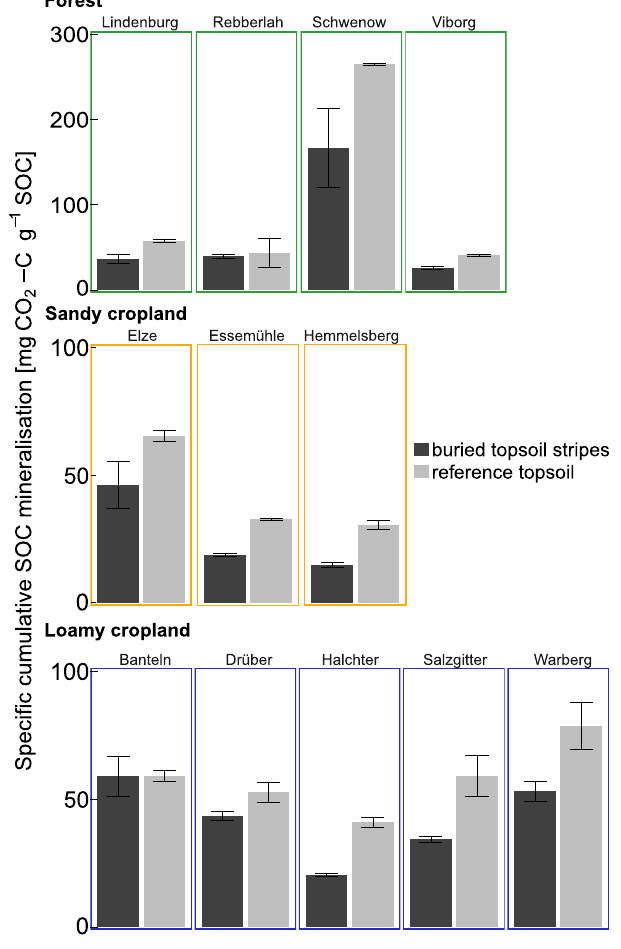
Figure 3. Specific cumulative SOC mineralisation after one year of incubation. Bars represent mean values from laboratory replicates (n = 3), whiskers show standard